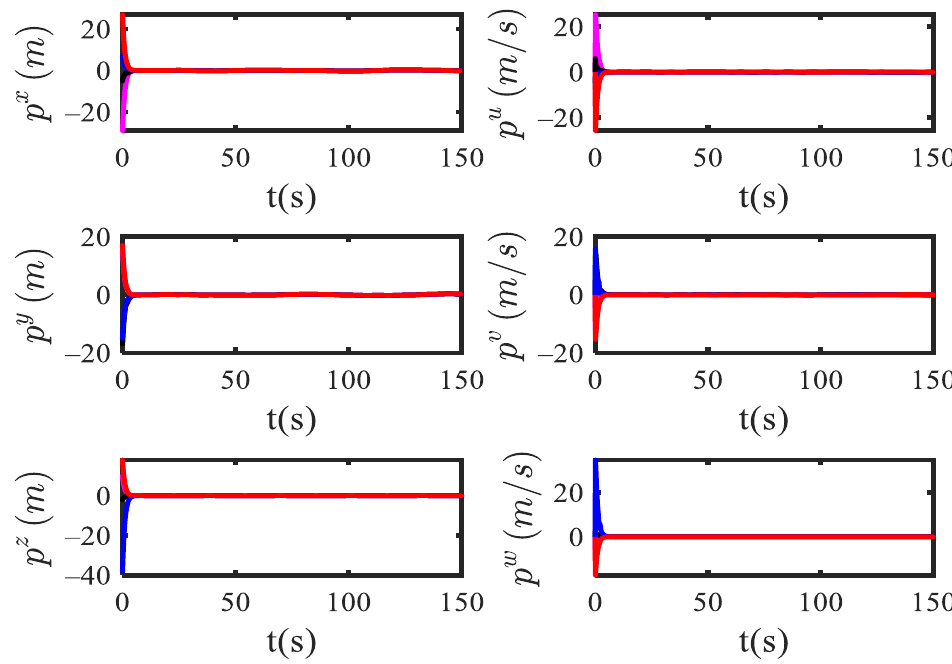
Figure 7. Distance between any two UUVs of the formation with collision avoidance. The position error and velocity error performance are validated as shown in Figure 8. All the errors converge to zero in finite time, which means that the controller works satisfactorily and the system is stable. Simulation results show the four UUVs can track the virtual leader well without collision and maintain a good formation.